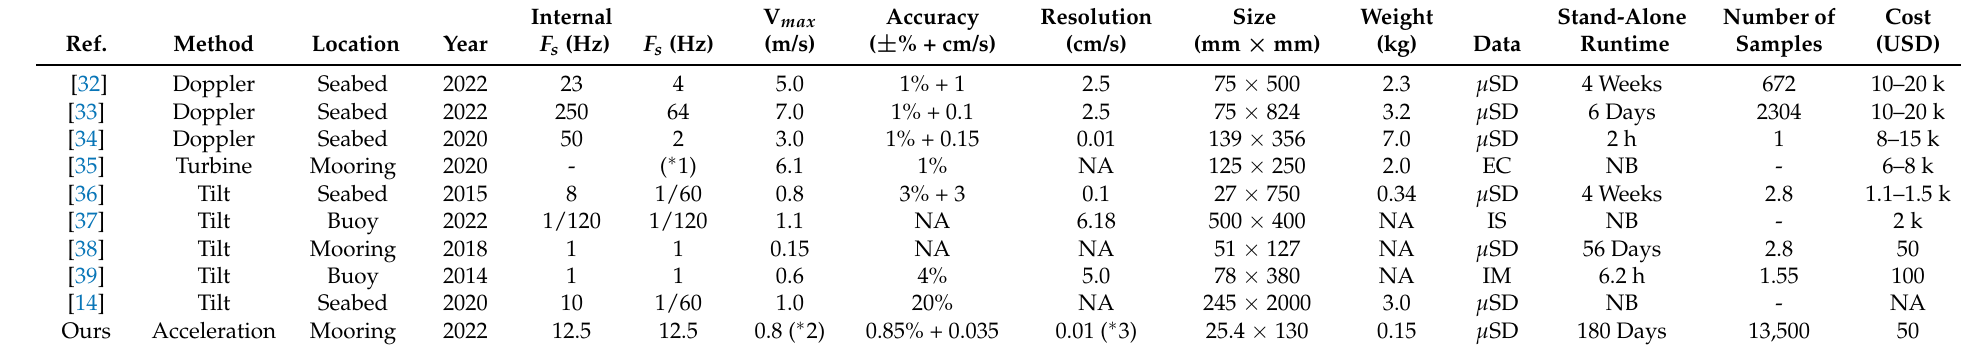
Table 3. Comparisons between approaches in the literature, industry solutions and our